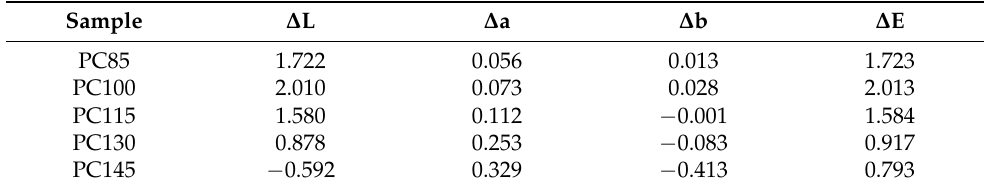
Table 2. The chromatic aberration and ∆ E values of the GF-PC composites after aged. Sample ∆ L ∆ a ∆